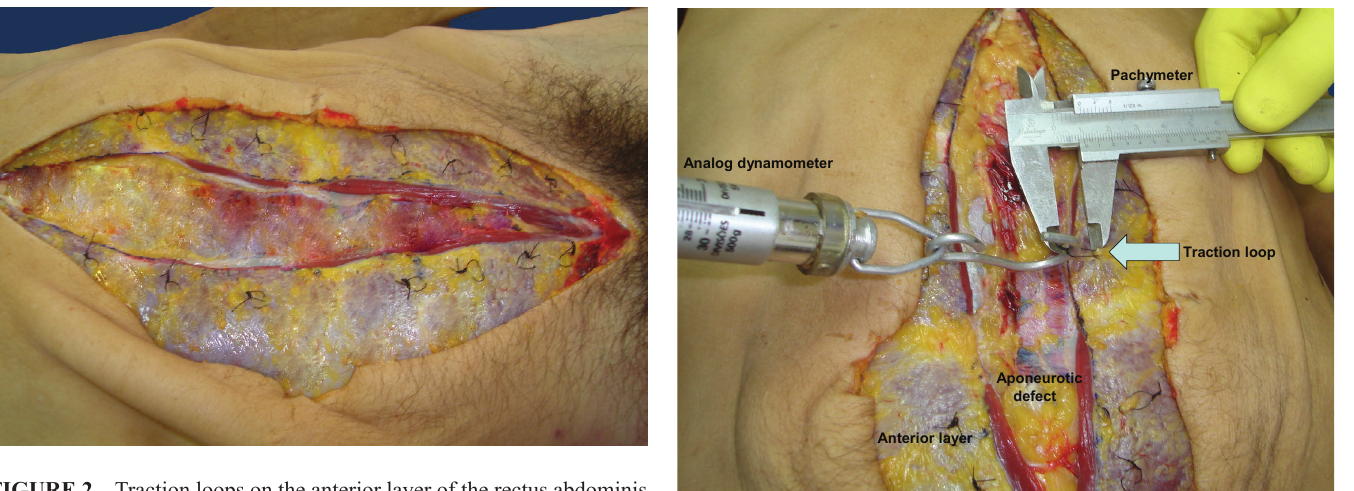
FIGURE 2 – Traction loops on the anterior layer of the rectus abdominis muscle.